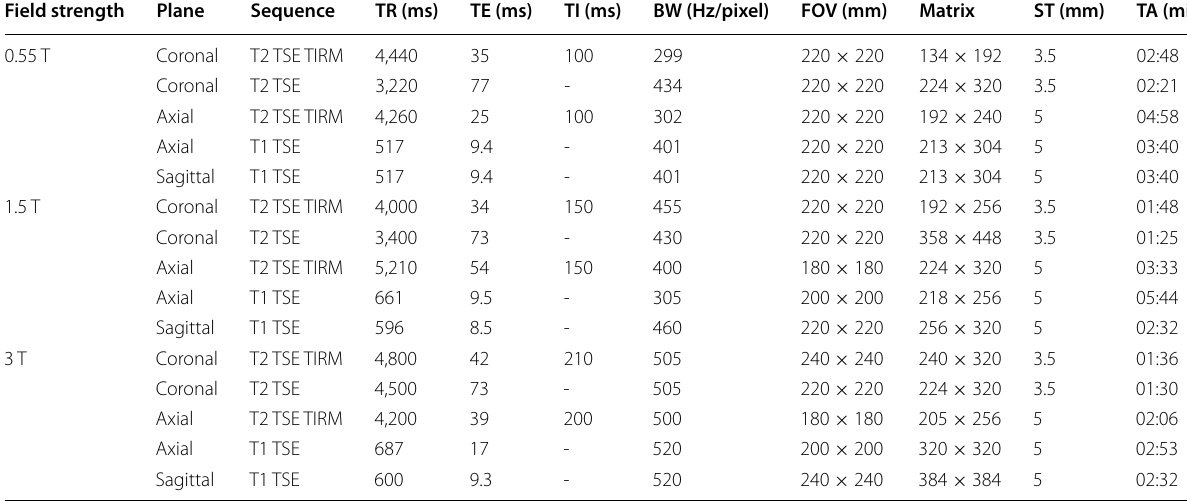
Table 2 Imaging protocols and pulse sequence parameters for 0.55‑T, 1.5‑T and 3‑T scanner systems